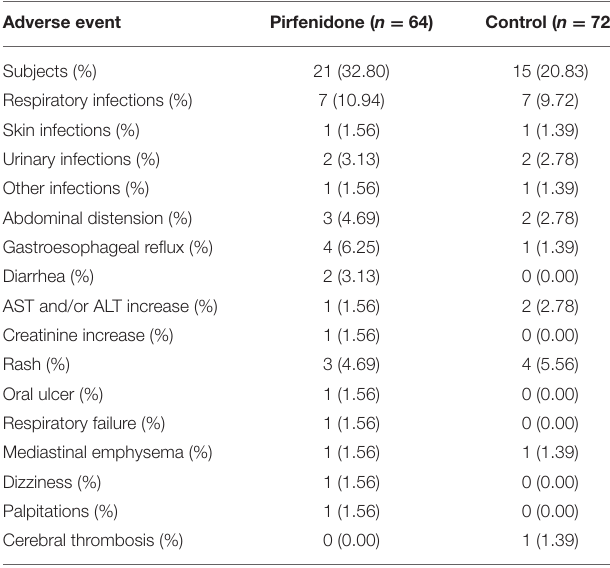
TABLE 5 | Comparison of adverse events in the PFD and control groups over 24